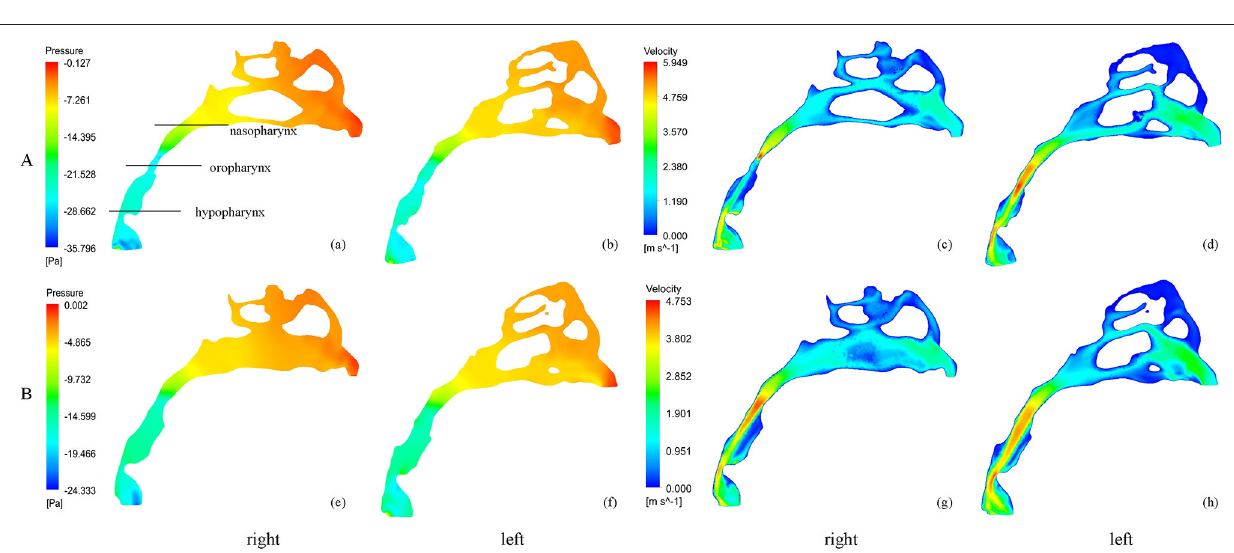
FIGURE 2 | The pressure and velocity profile of the airflow before and after RME. (A) before RME, (B) after